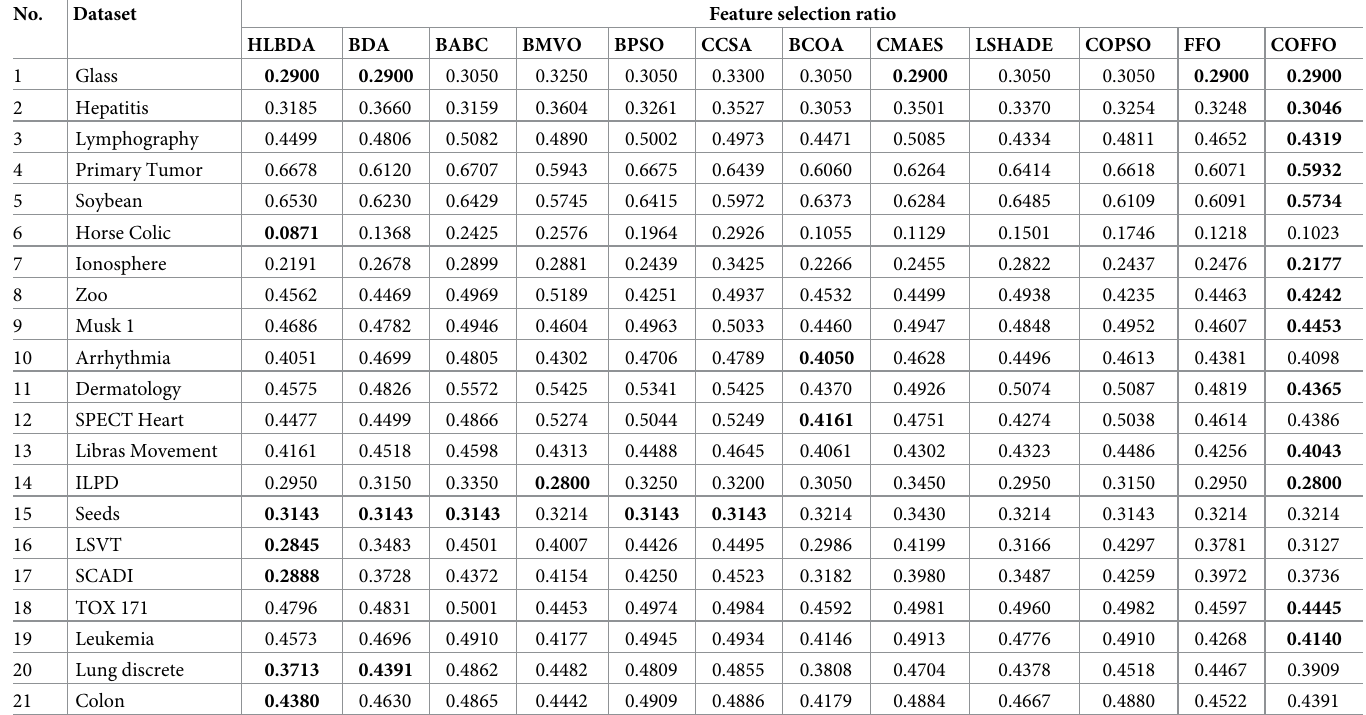
Table 12. Feature selection ratio results for tested